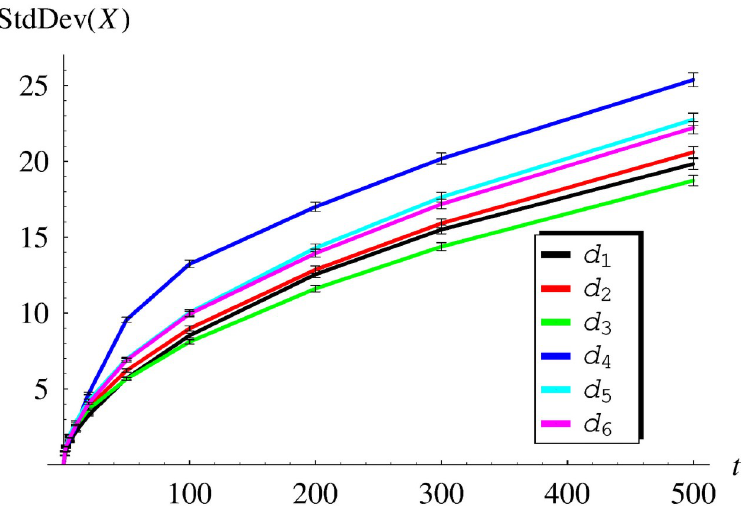
Fig 2. The standard deviation of the queue size versus time for dropping functions d 1 − d 6 . The confidence intervals for the confidence level of 0.99 are added.